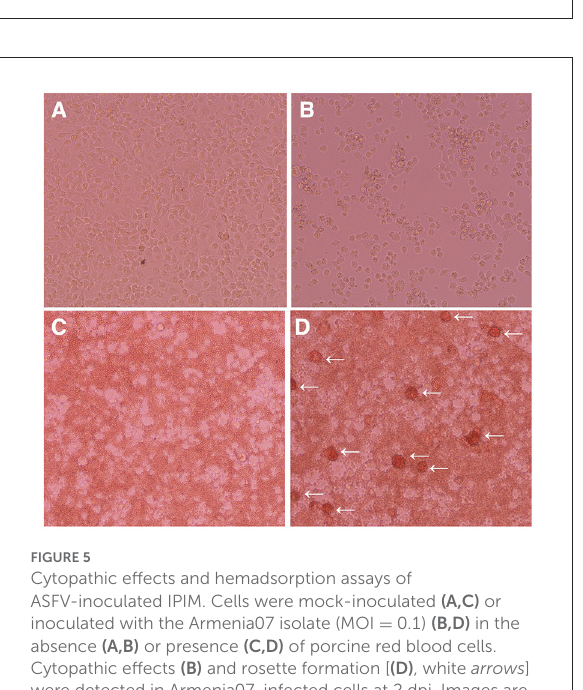
FIGURE5 Cytopathic effects and hemadsorption assays of ASFV-inoculated IPIM. Cells were mock-inoculated (A,C) or inoculated with the Armenia07 isolate (MOI = 0.1) (B,D) in the absence (A,B) or presence (C,D) of porcine red blood cells. Cytopathic effects (B) and rosette formation [ (D) , white arrows ] were detected in Armenia07-infected cells at 2 dpi. Images are representative of at least three independent experiments.